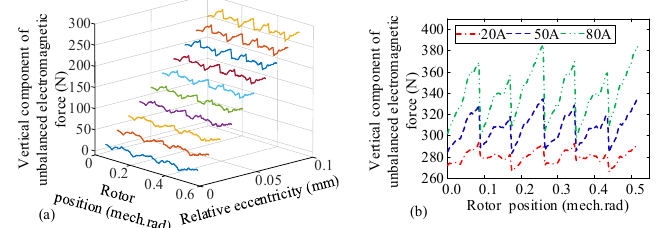
Figure 4. The characteristics of unbalanced electromagnetic force (UEF): ( a ) under different rotor position and eccentricity; ( b ) under different rotor position and phase current.